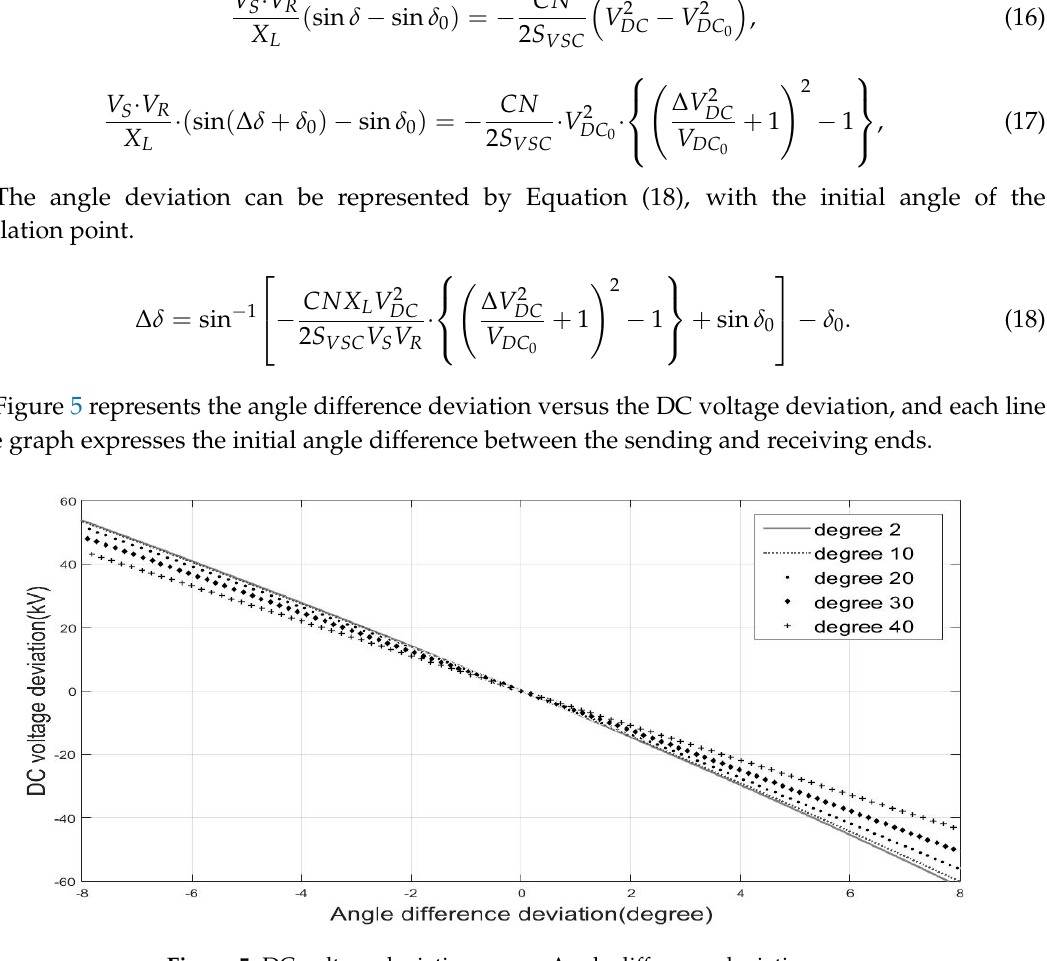
Figure 5. DC voltage deviation versus Angle difference deviation.